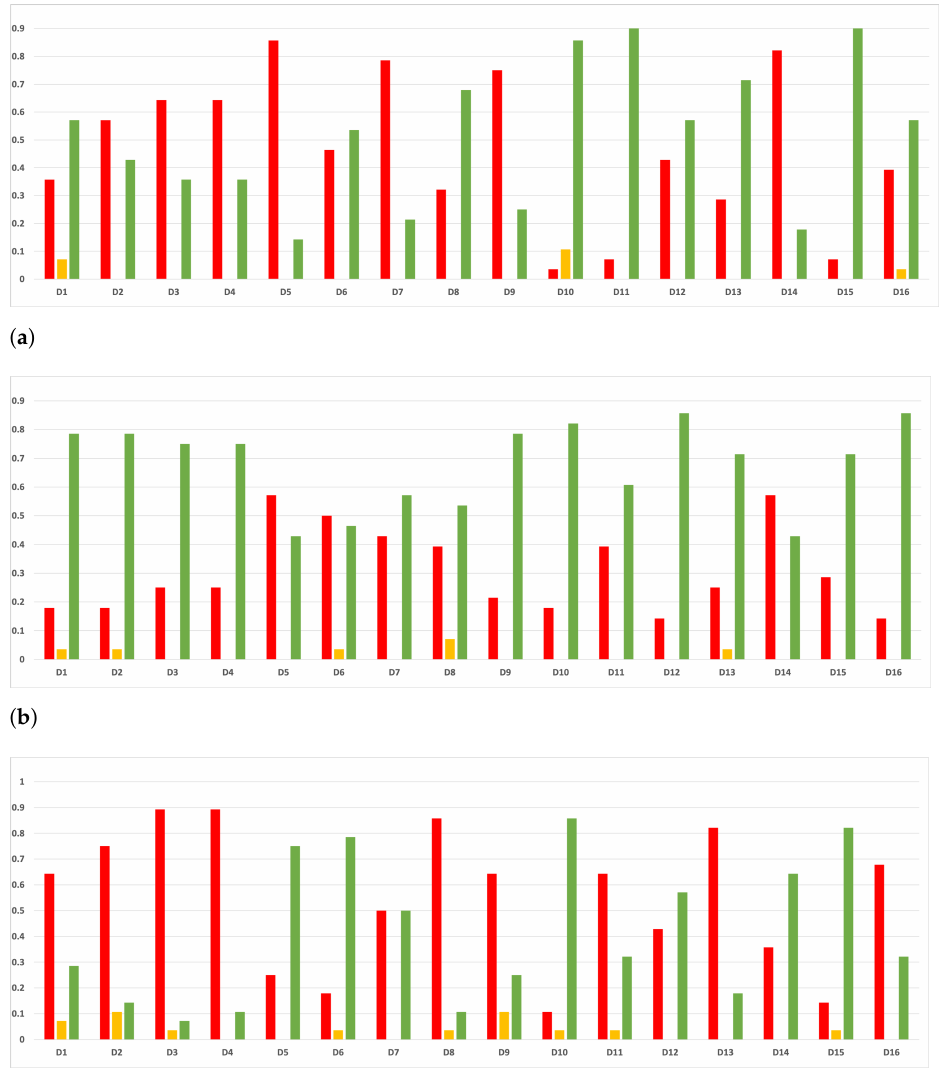
Figure 21. Experiment 2: consistency per dataset. Rate of validity with the accuracy and time complexity. ( a ) Rate of validity per dataset in RF. In axis X, the dataset. In axis Y, the rate of RHOASo for each class of validity. ( b ) Rate of validity per dataset in GB. In axis X, the dataset. In axis Y, the rate of RHOASo for each class of validity. ( c ) Rate of validity per dataset in MLP. In axis X, the dataset. In axis Y, the rate of RHOASo for each class of